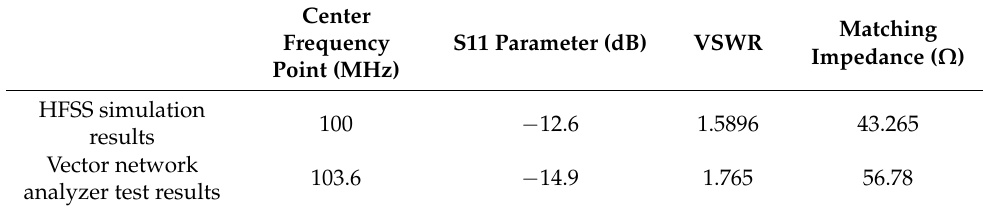
Figure 16. The vector network analyzer test. Table 1. Comparison of the simulation results and detection results.